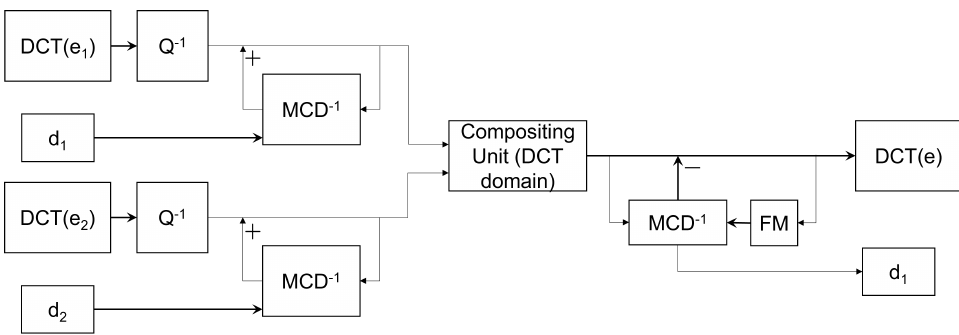
Figure 10. Compositing two DCT-based video sequences in DCT